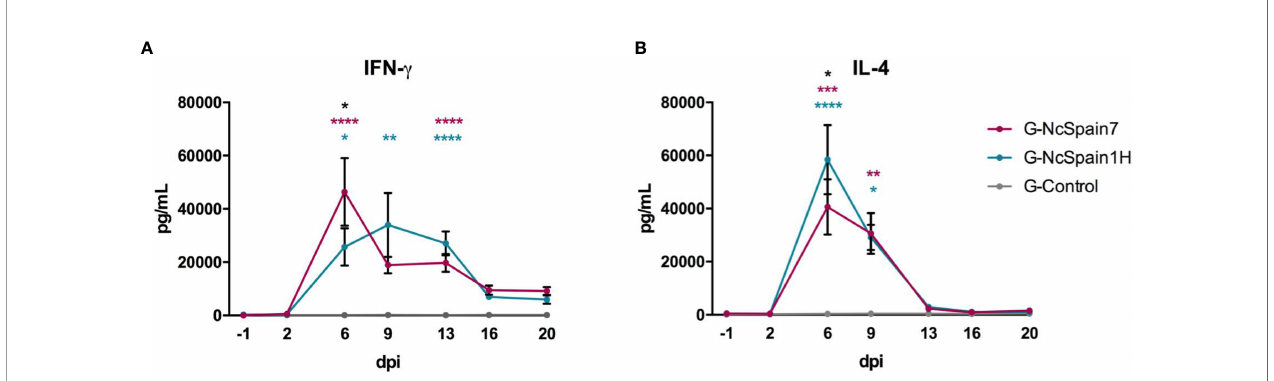
FIGURE 1 | IFN- g and IL-4 production after Nc-Spain7 and Nc-Spain1H infection. Concentrations of (A) IFN- g and (B) IL-4 in response to N. caninum soluble extract antigen, in peripheral blood culture supernatants of heifers challenged with Nc-Spain7 (G-NcSpain7) and Nc-Spain1H (G-NcSpain1H) tachyzoites and the uninfected control group (G-Control). Each point represents the mean+SD at different sampling times. Asterisks indicate signi fi cant differences in G-NcSpain1H versus G-Control comparison (blue), G-NcSpain7 versus G-Control (red) and G-NcSpain1H versus G-NcSpain7 (black). **** P <0.0001, *** P <0.001, ** P <0.01, *